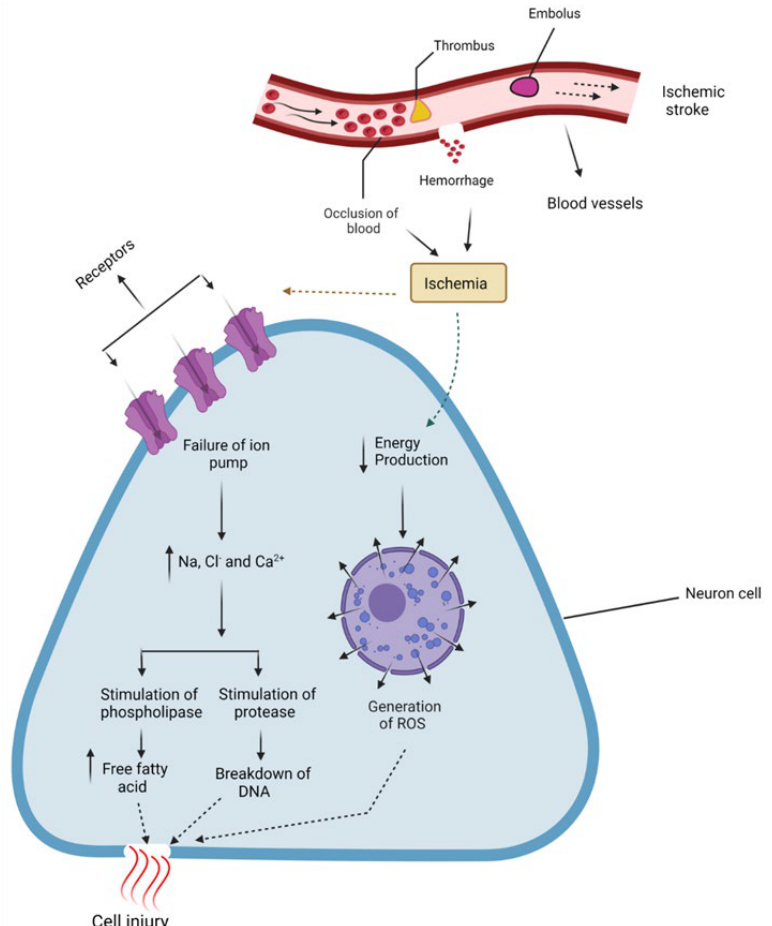
Figure 1. Pictorial presentation of ischemic stroke, the consequence of reduced blood supply due to occlusion of the main cerebral artery, either temporarily or permanently. In this way, the central core becomes devoid of blood supply, and energy-dependent cell pumps malfunction, causing a build-up of Na+ and Ca+ and decreased energy production leading to the generation of Reactive Oxygen Species (ROS), and resulting in neuronal